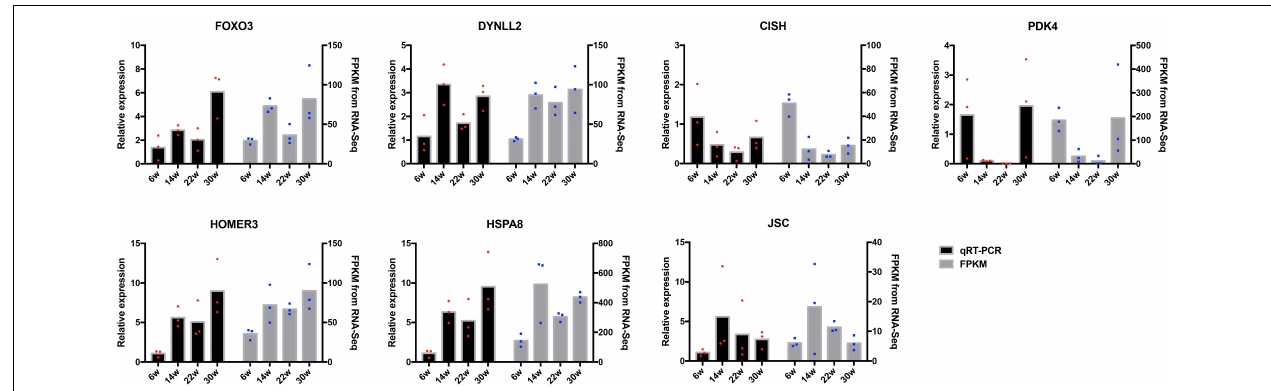
FIGURE 7 | Quantitative real-time PCR (qRT-PCR) validation of differentially expressed mRNAs. The red dots indicate the biological repetition in qRT-PCR result. The blue dots indicate the biological repetition from RNA-seq.